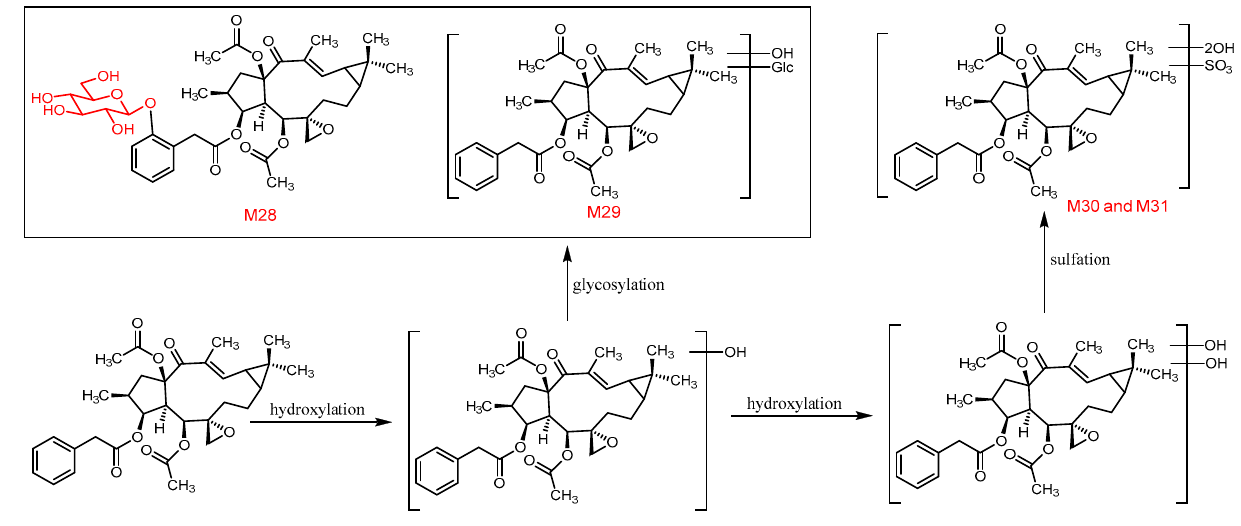
Figure 12. The proposed metabolic pathway of euphorbiasteroid in rats ( Ⅳ ).